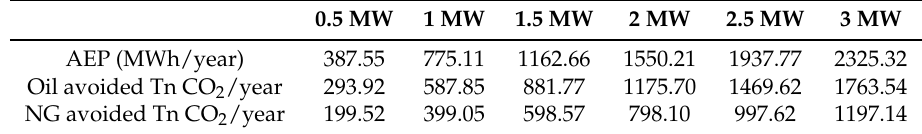
Table 2. Annual energy production and displacement of emissions by dominant fuel